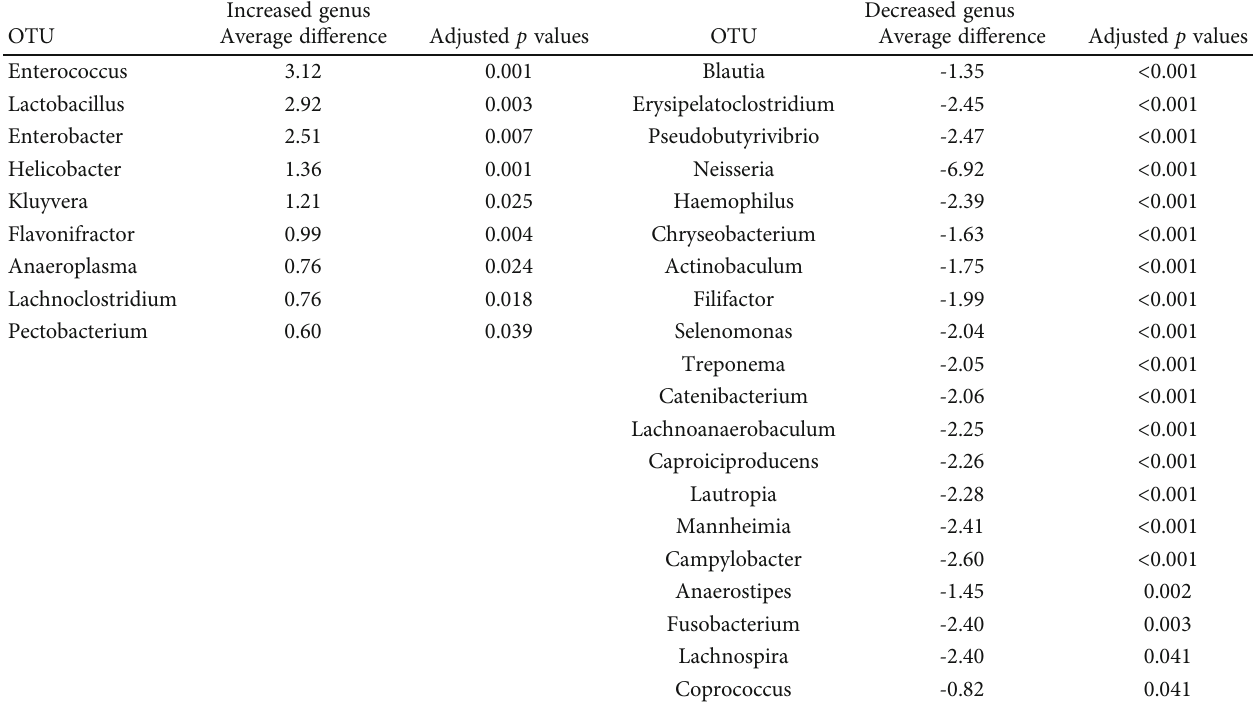
Table 3: Top 20 signi fi cantly increased/decreased genus in the poststroke